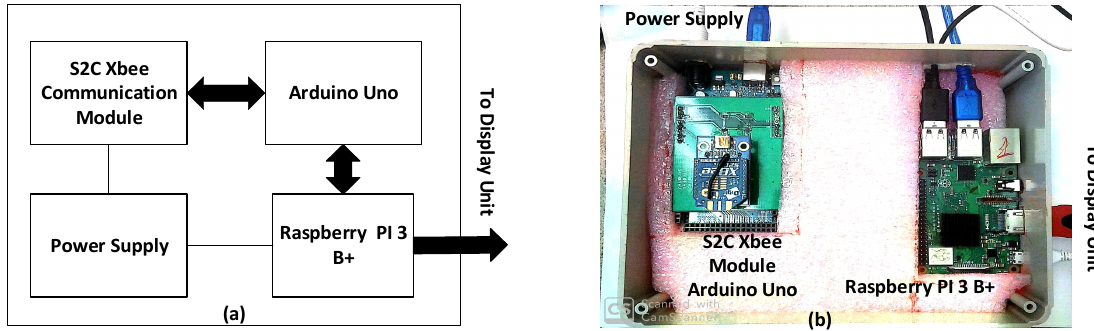
Figure 3. Gateway node, ( a ) block diagram, and ( b ) prototype.